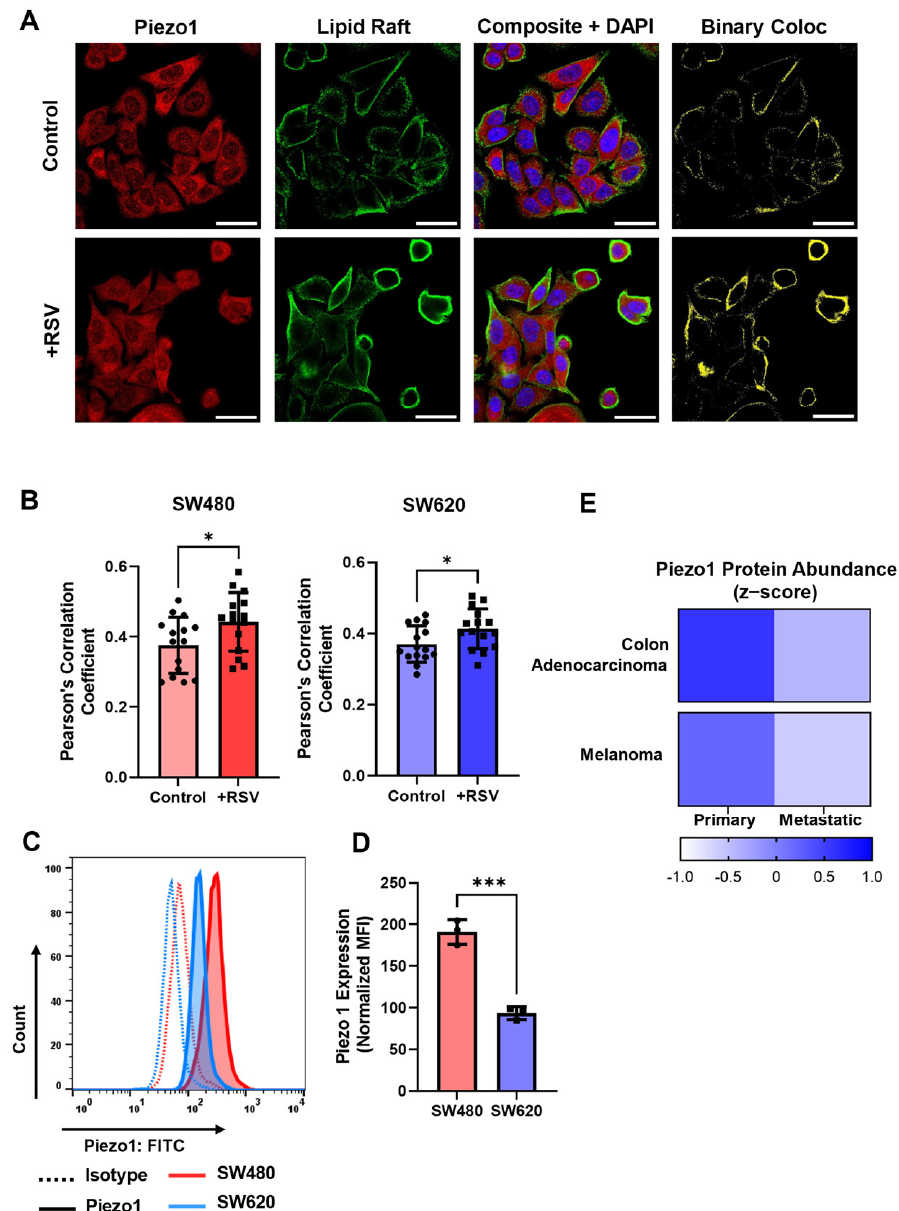
Figure 7. Resveratrol increases LR/Piezo1 colocalization, and SW480 cells have higher Piezo1 ex- pression. ( A ) Confocal microscopy images of Piezo1 (red), lipid rafts (green), DAPI (blue), and colocalization events between Piezo1 and LR (yellow). Scale bar = 30 µ m. ( B ) Pearson’s correlation coefficient between LR/Piezo1 was calculated using the JACoP plugin in ImageJ. N = 3 ( n = 15 images), * p < 0.05, *** p < 0.001 (two-tailed unpaired t-test). For all plots, error bars represent mean ± SD. ( C ) Expression of Piezo1 (solid line) and isotype controls (dashed lines) in SW480 (red) and SW620 (blue) cells. ( D ) Median fluorescence intensity of Piezo1 normalized to the respective isotype control. N = 3, *** p < 0.001 (two-tailed unpaired t -test). ( E ) Protein abundance data (z-scores) from the Broad Cancer Cell Line Encyclopedia, downloaded from cBioPortal. Primary tumor and lymph node metastases from the same patient with colon adenocarcinoma (SW480 and SW620) and mela- noma (WM115 and WM2664). Darker blue represents a higher z-score and higher Piezo1 abun- dance.